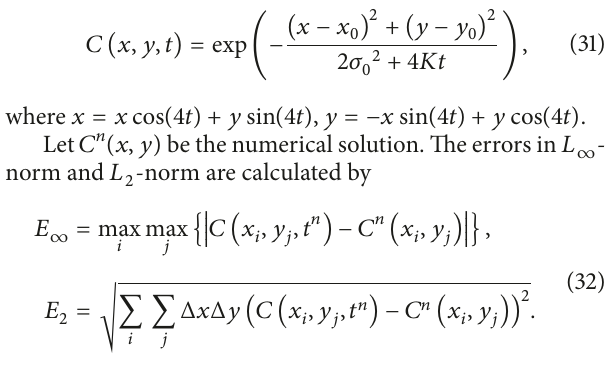
in domain Ω = [−1, 1] × [−1, 1] and on [0, 𝑇] = [0, 𝜋/4] . The initial center is (𝑥 0 , 𝑦 0 ) = (−0.4, 0) and 𝜎 02 = 0.01 . Besides, the diffusion coefficient 𝐴 𝐻 and the source and sink terms of pollutants 𝜃 are set to 0.0001 and 0, respectively. The variable velocity field is 𝑢 = −4𝑦, V = 4𝑥 .